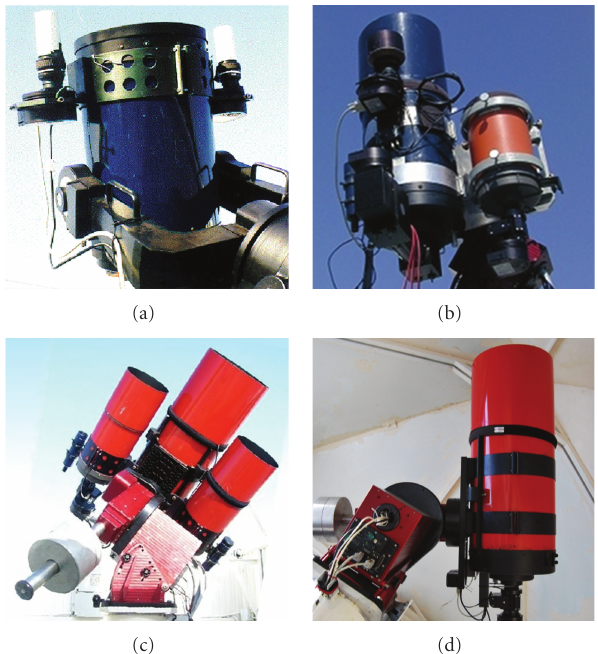
Figure 1: Four historic BOOTES-1B configurations.